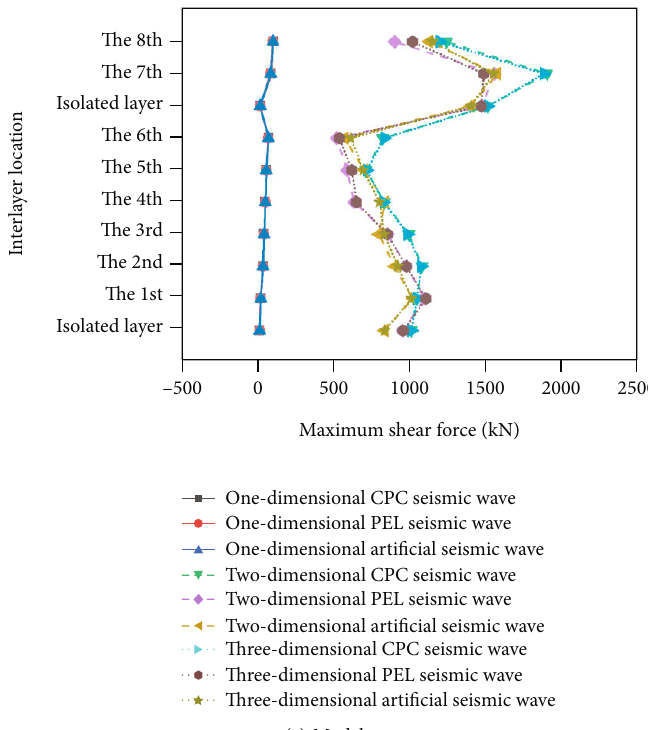
Figure 8: Comparison of interlayer shear force in Y -direction of di ff erent